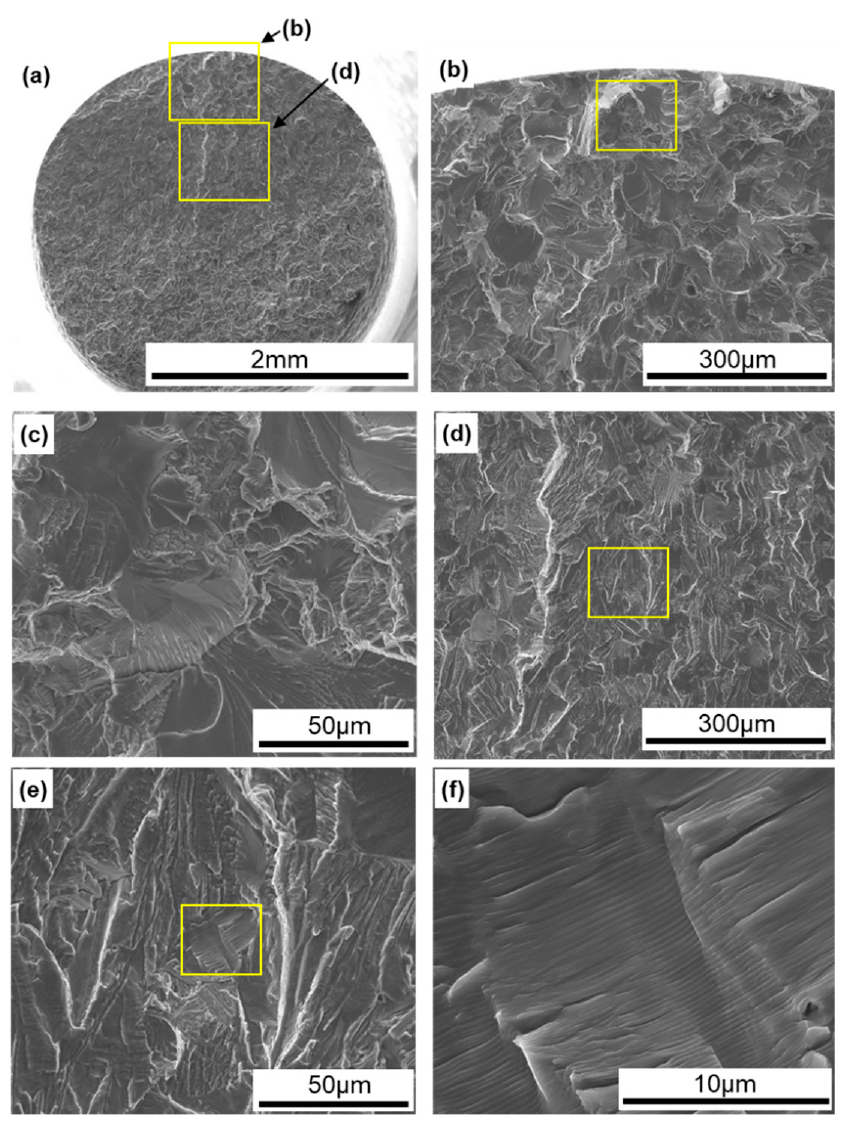
Figure 12. SEM images of fracture surfaces of fatigue-tested TILOP CP Ti G 2 (once-sintered 0°); ( b ) magnification of upper rectangular area in ( a ), ( c ) magnification of rectangular area in ( b ), ( d ) magnification of lower rectangular area in ( a ), ( e ) magnification of rectangular area in ( d ), and ( f ) magnification of rectangular area in ( e ).